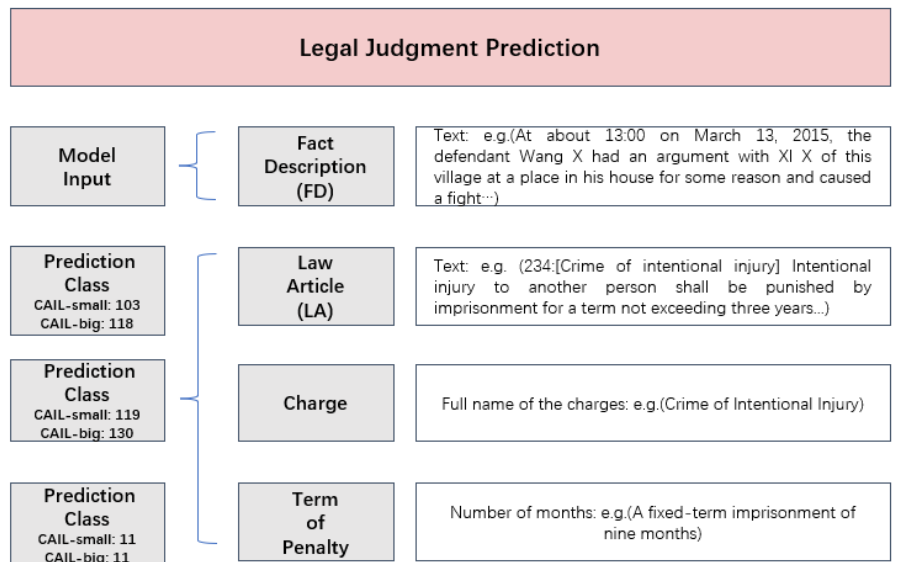
Figure 3. An example of LJP. The model’s input is fact description and we need to predict law articles, charges and terms of penalty. The number of classes for the three tasks on the CAIL-small dataset are 103, 119 and 11; the number on the CAIL-big dataset are 118, 130 and